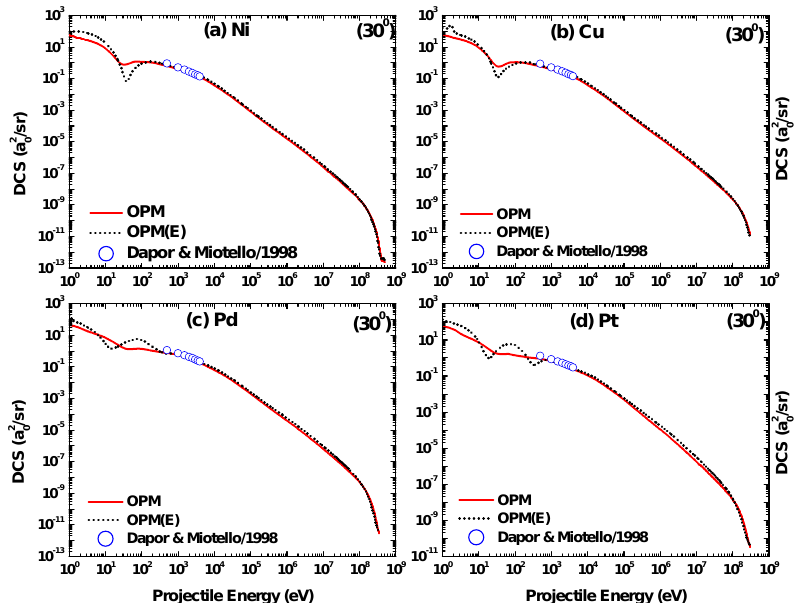
Figure 23. Energy-dependent differential cross-sections for positron scattering (——-) from ( a ) Ni 58 , ( b ) Cu 63 , ( c ) Pd 108 , and ( d ) Pt 196 at a scattering angle θ = 30 ◦ . The calculations of Dapor and Miotello [50] are shown as well. The electron scattering results ( · · · · · · ) from Figure 15 are included here for comparison.